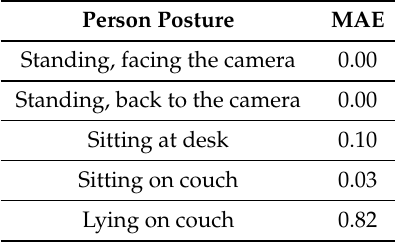
Table 12. Average counting errors of the detection component by person postures.